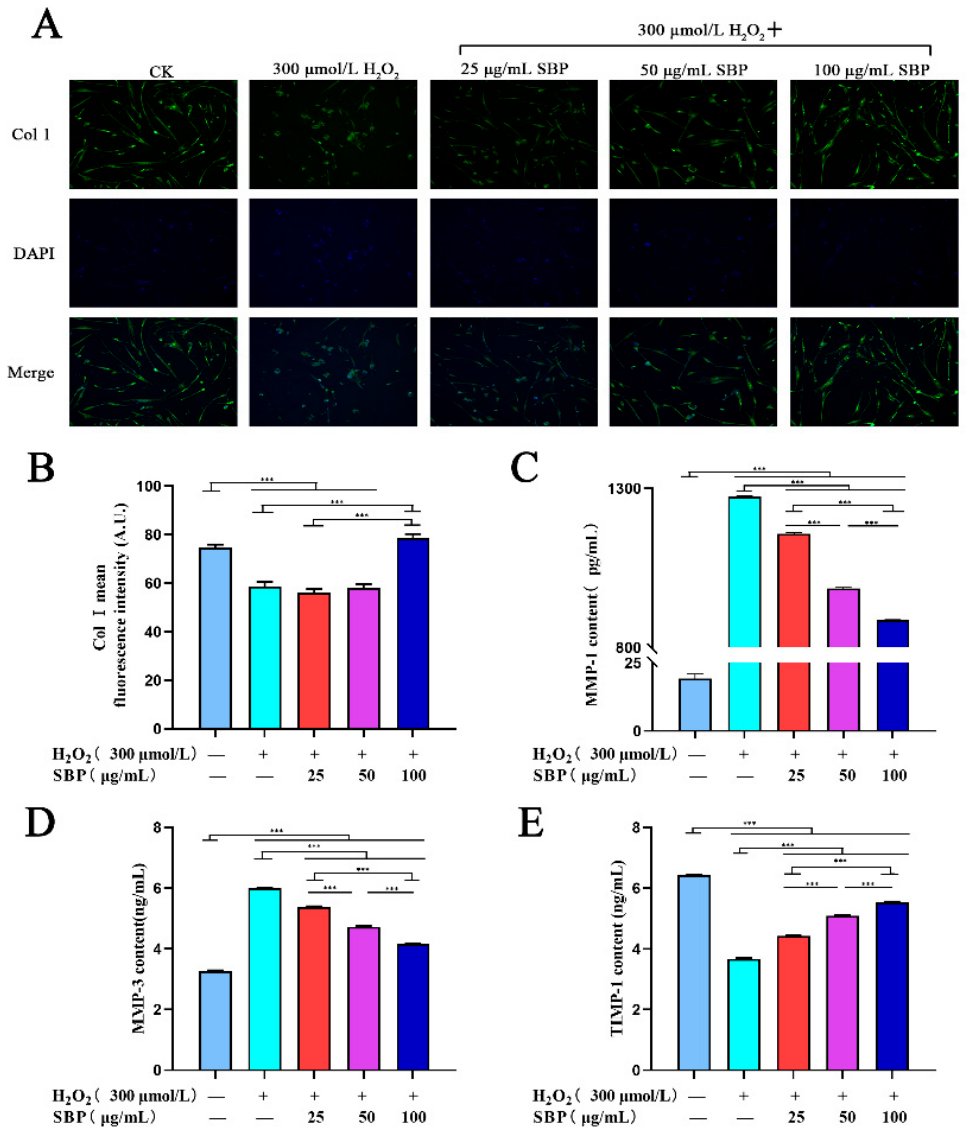
Figure 4. Effects of SBP on Col I expression in H 2 O 2 -induced senescent HSFs. ( A ): Representative immunofluorescence microscopy image showing the Col I levels in cells under different experimental treatments with Col I in green and DAPI-stained nuclei in blue. ( B ): Mean fluorescence intensity of Col I in cells under the different experimental conditions. ( C – E ): Concentrations of MMP-1, MMP-3, and TIMP-1 in different experimentally treated cells using the ELISA kit. In the figure “+” means added, “ − ” means not added. The results are the mean ± SD of three independent experi- ments. *** p < 0.001 indicate significant differences compared with the various experimental groups.